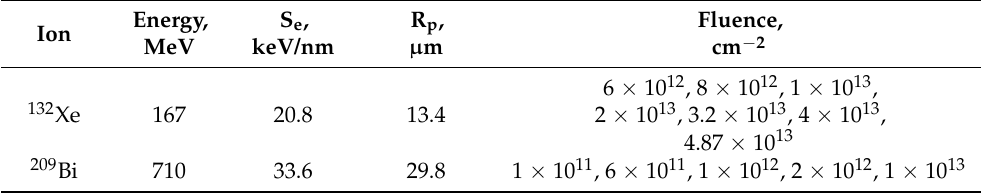
Table 1. The ion irradiation